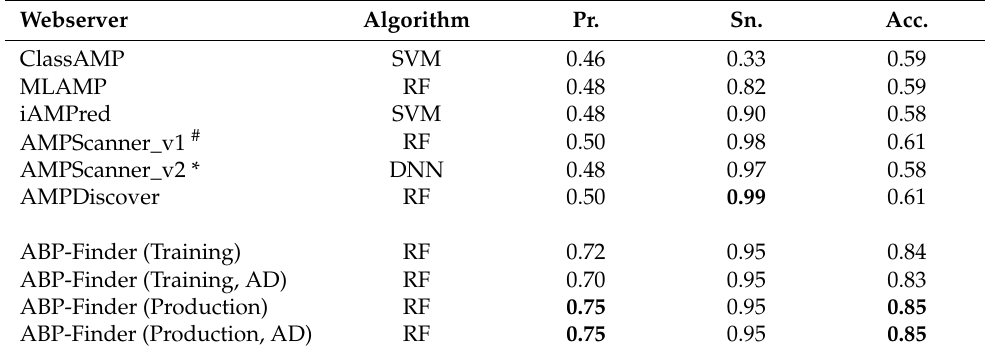
Table 2. Comparison with external predictors in the validation set. The values in bold denote the best performance for a given measure.